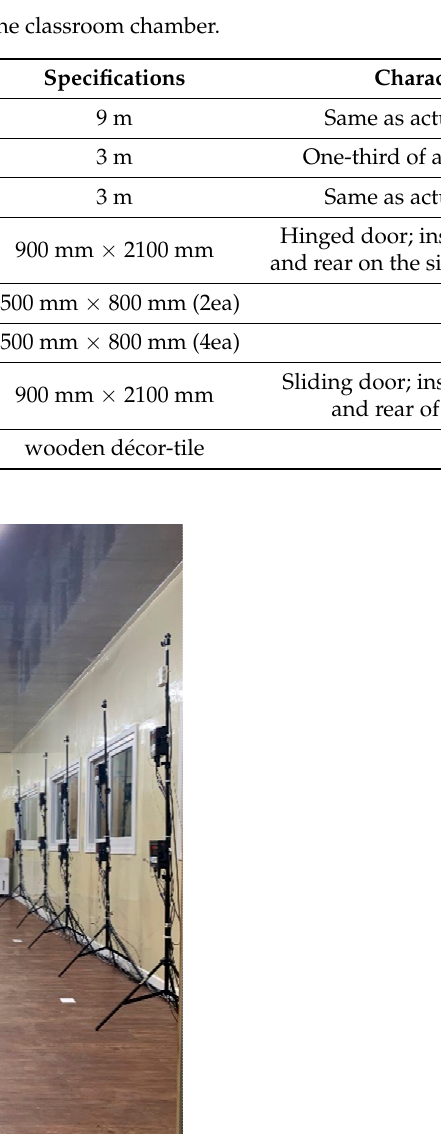
Figure 1. Inside the classroom chamber (Note: cube-shaped devices on the poles are simple particulate matter (PM) measurement devices but they were not used in this study).